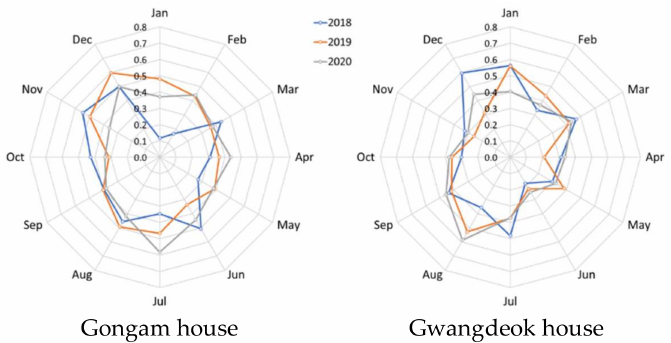
Figure 10. Monthly supply cover